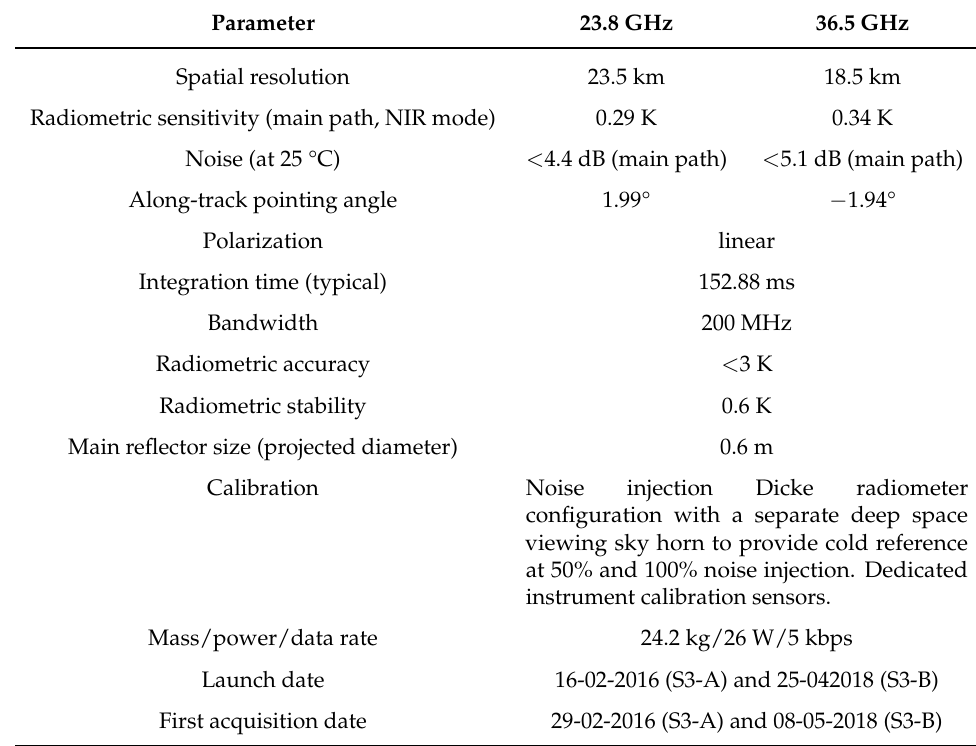
Table 1. Key characteristics of the MWR flown on the Sentinel-3 series of satellites. Source: